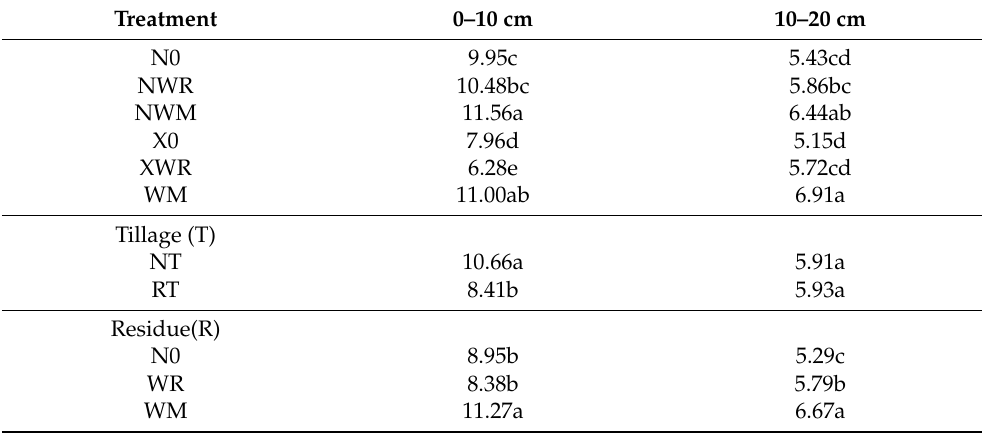
Table 2. SOC concentration in the 0–10 cm and 10–20 cm soil layers in field experiments under different